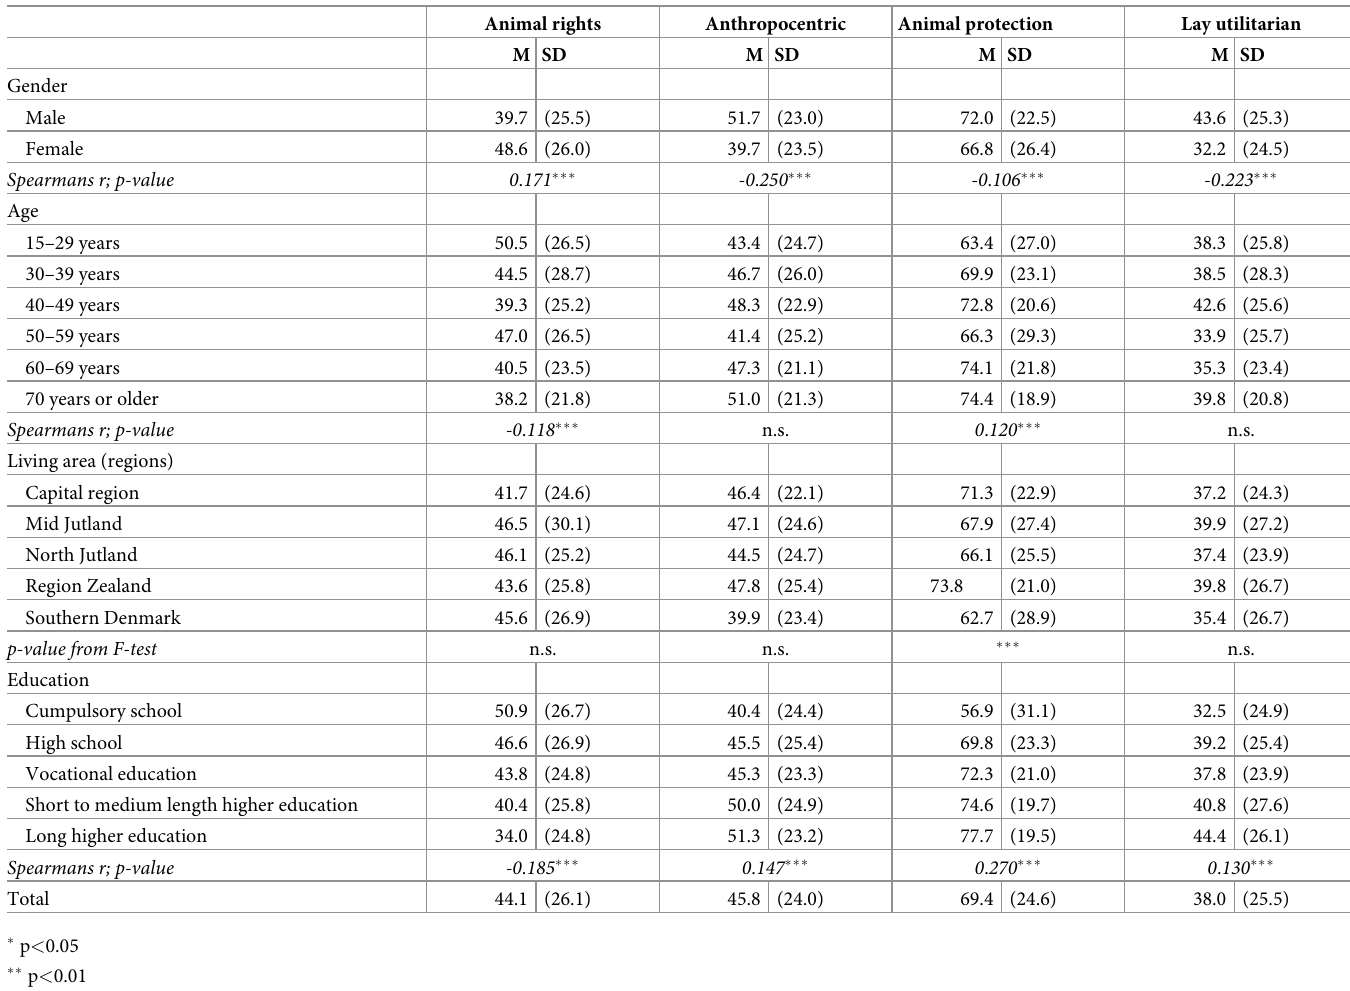
Table 3. The animal ethics orientations scores in socio-demographic sectors (N =